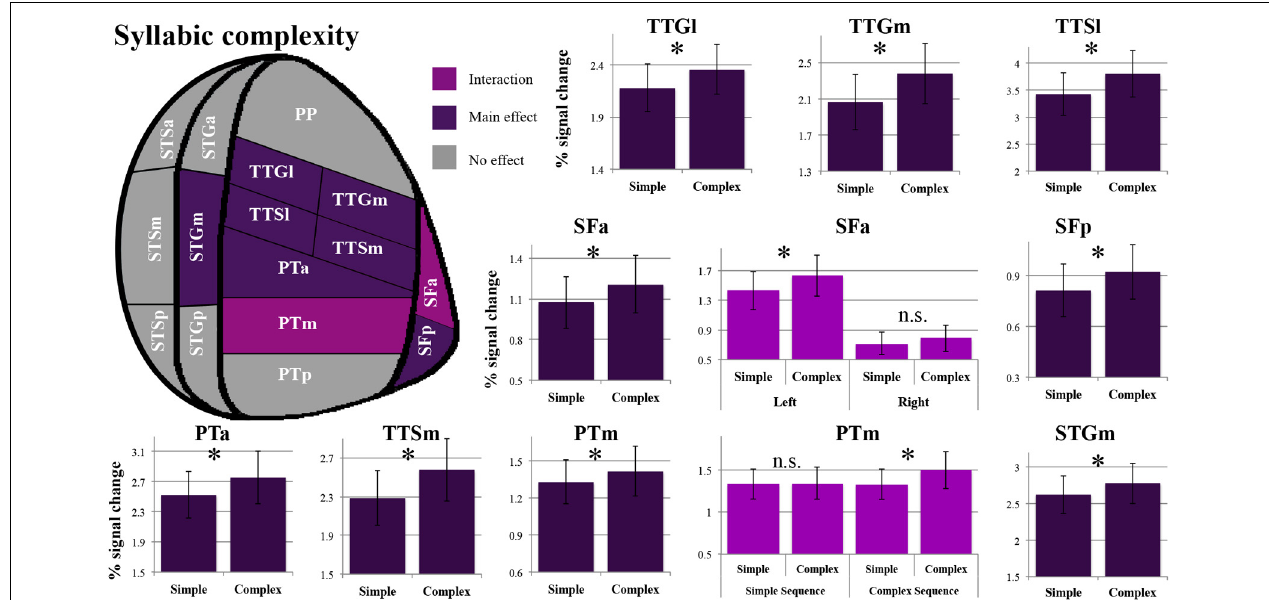
planum polare; TTG, transverse temporal gyrus ( m , medial; l, lateral); TTS, transverse temporal sulcus (m, medial; l, lateral); PT, planum temporale (a, anterior; m, middle; p, posterior); SF, caudal Sylvian fissure (a, anterior; p, posterior); STG, superior temporal gyrus (a, anterior; m, middle; p, posterior); STS, superior temporal sulcus (a, anterior; m, middle; p, posterior); ∗ significant contrast at p = 0 . 05, Bonferonni corrected; n.s. FWE non-significant contrast. Error bars represent standard error of the